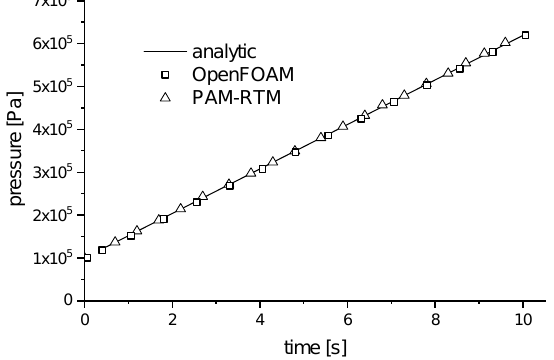
Figure 5. Pressure increase at the inlet while Injection-RTM boundary conditions are